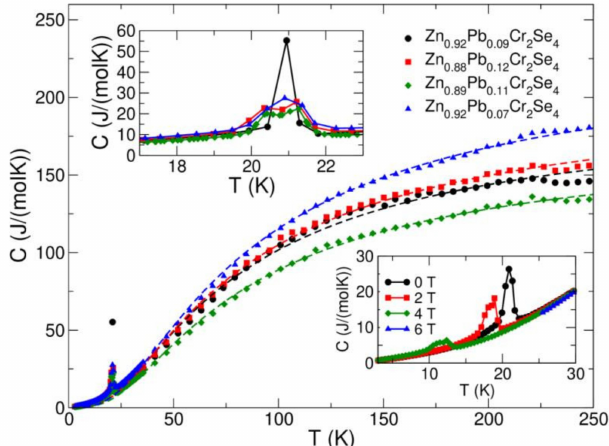
Figure 10. Specific heat, C , as a function of temperature T , measured for the Zn 1 − x Pb x Cr 2 Se 4 single crystals (x = 0.07, 0.09, 0.11, and 0.12) at zero magnetic field (main figure). The dashed lines show the Debye model fit experimental data for T > 40 K. The upper inset shows how the magnetic peak is affected by Pb substitution. The lower inset shows how the magnetic transition temperature is affected by the magnetic field for the Zn 0.92 Pb 0.07 Cr 2 Se 4 sample. Note that the temperature scales on the lower and upper inset are not the same. Hence, the peaks in the upper inset appear much broader than in the lower inset or the main